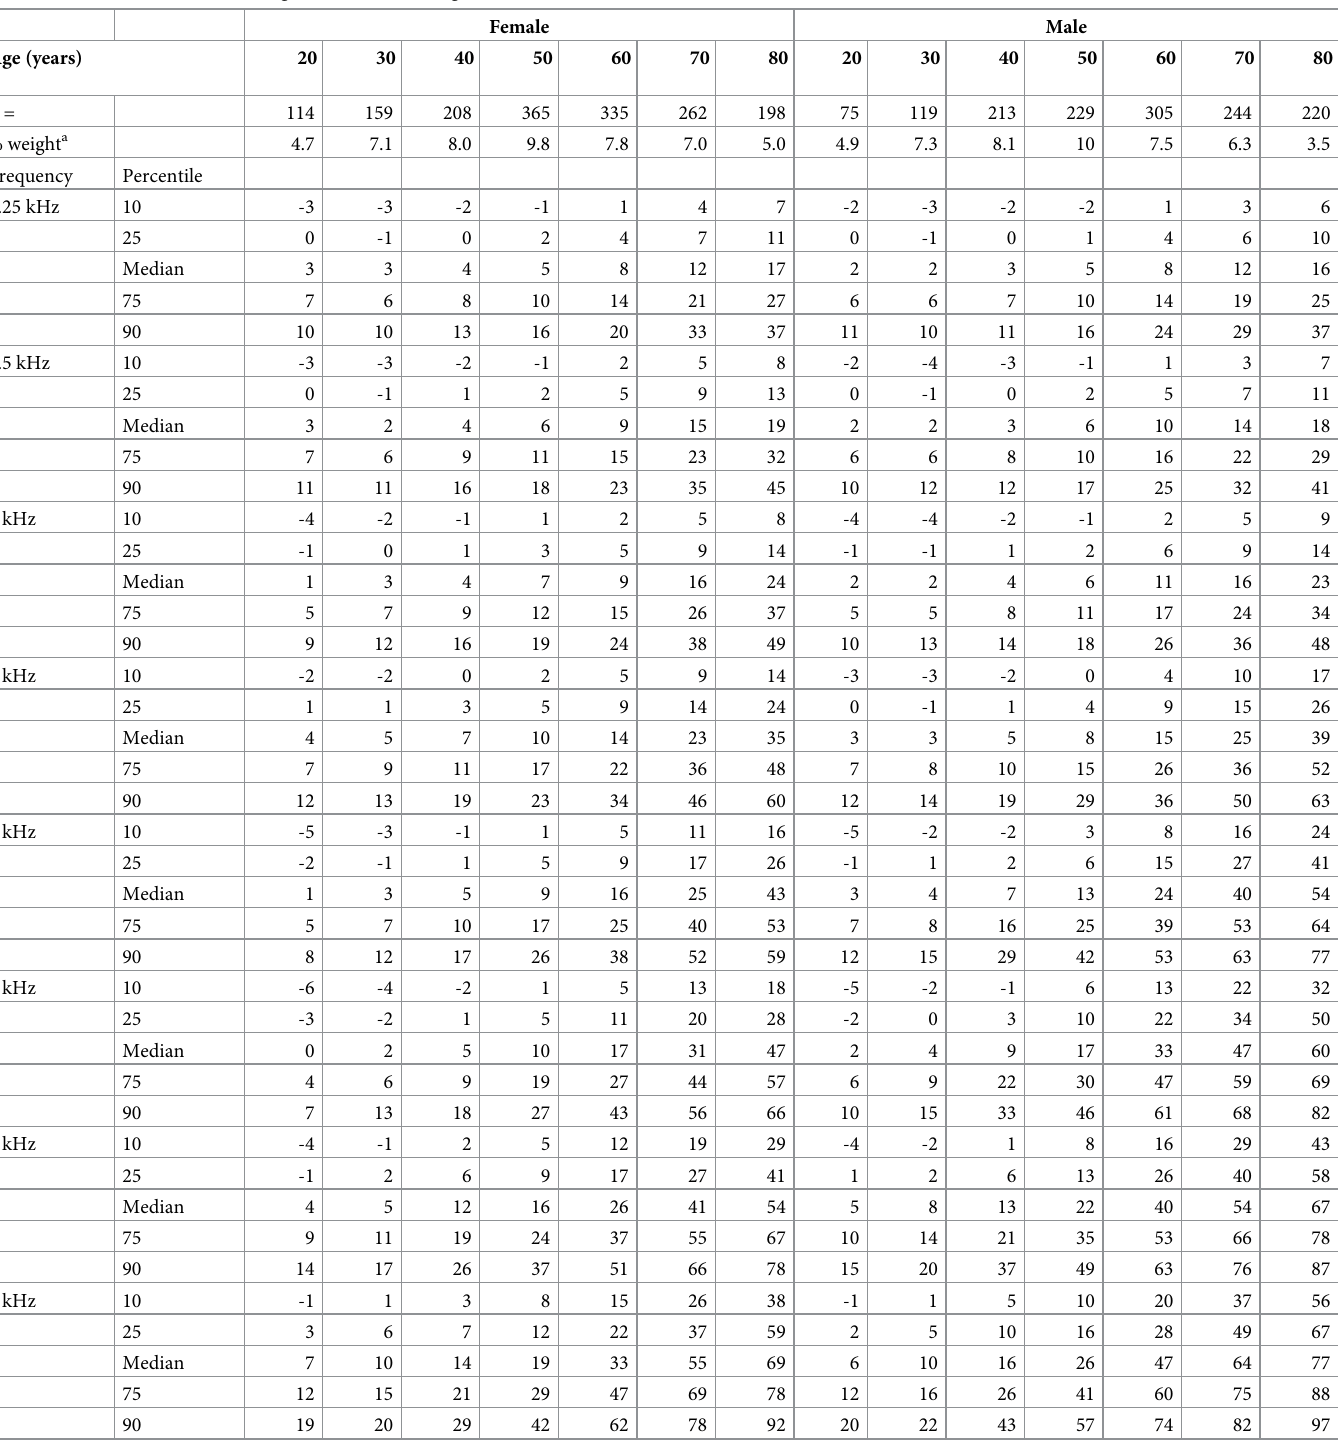
Table 1. Distribution of HTL averaged across left and right ears for females and males. Female